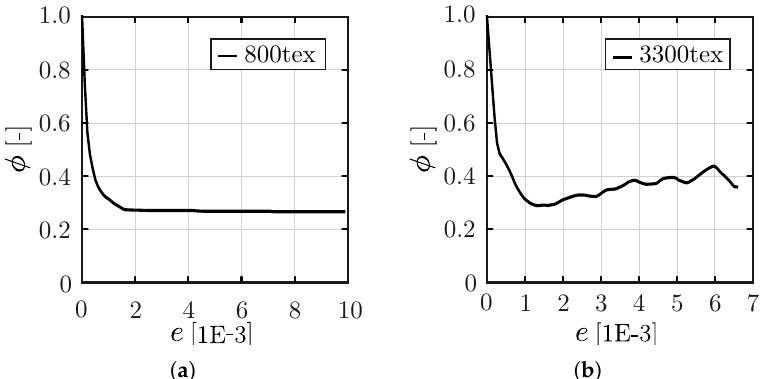
Figure 9. Calibration of integrity functions φ = ( 1 − ω ) using experimentally obtained stress–strain curves on 10 mm thick specimens reinforced with one layer of ( a ) 800 tex and ( b ) 3300 tex carbon fabrics.